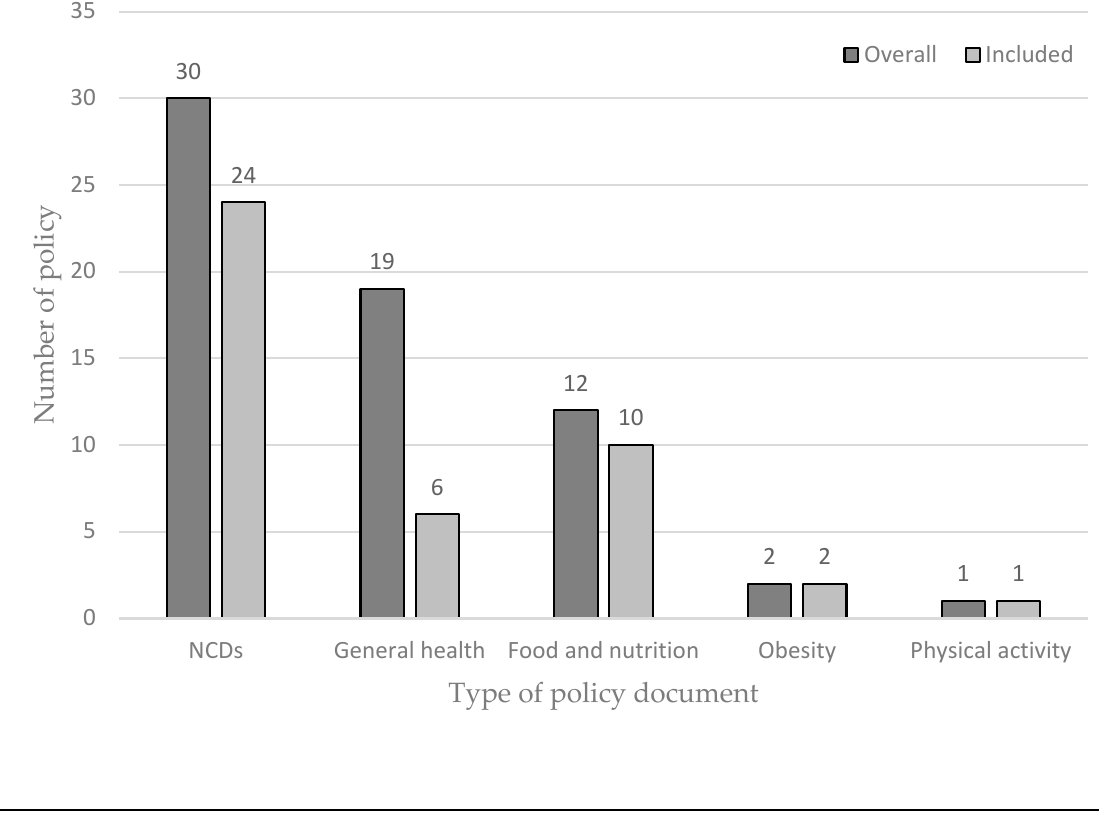
Figure 1. National policies reviewed, overall and included.